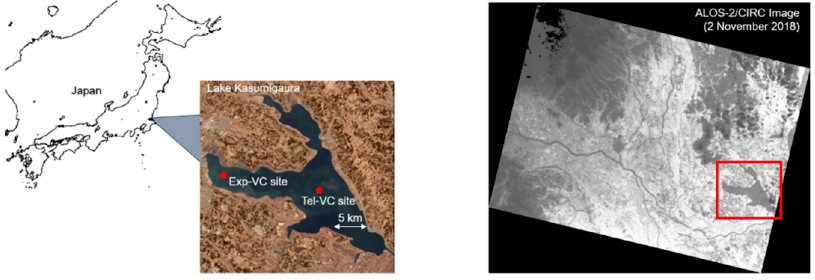
Figure 1. Locations of the experiment-based vicarious calibration (Exp-VC) and the telemetry-based vicarious calibration (Tel-VC) sites in Lake Kasumigaura ( left ) and the ALOS-2 / CIRC image acquired over the lake on 2 November 2018 ( right ).